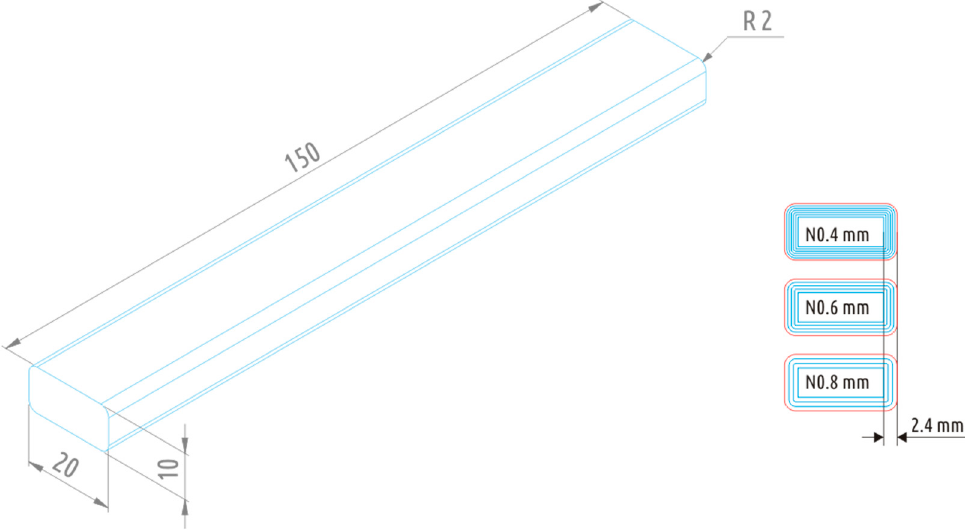
Figure 1. Solid model for fabrication of the testing sample and cross-sections of samples printed with 0.4, 0.6, and 0.8 mm nozzles.